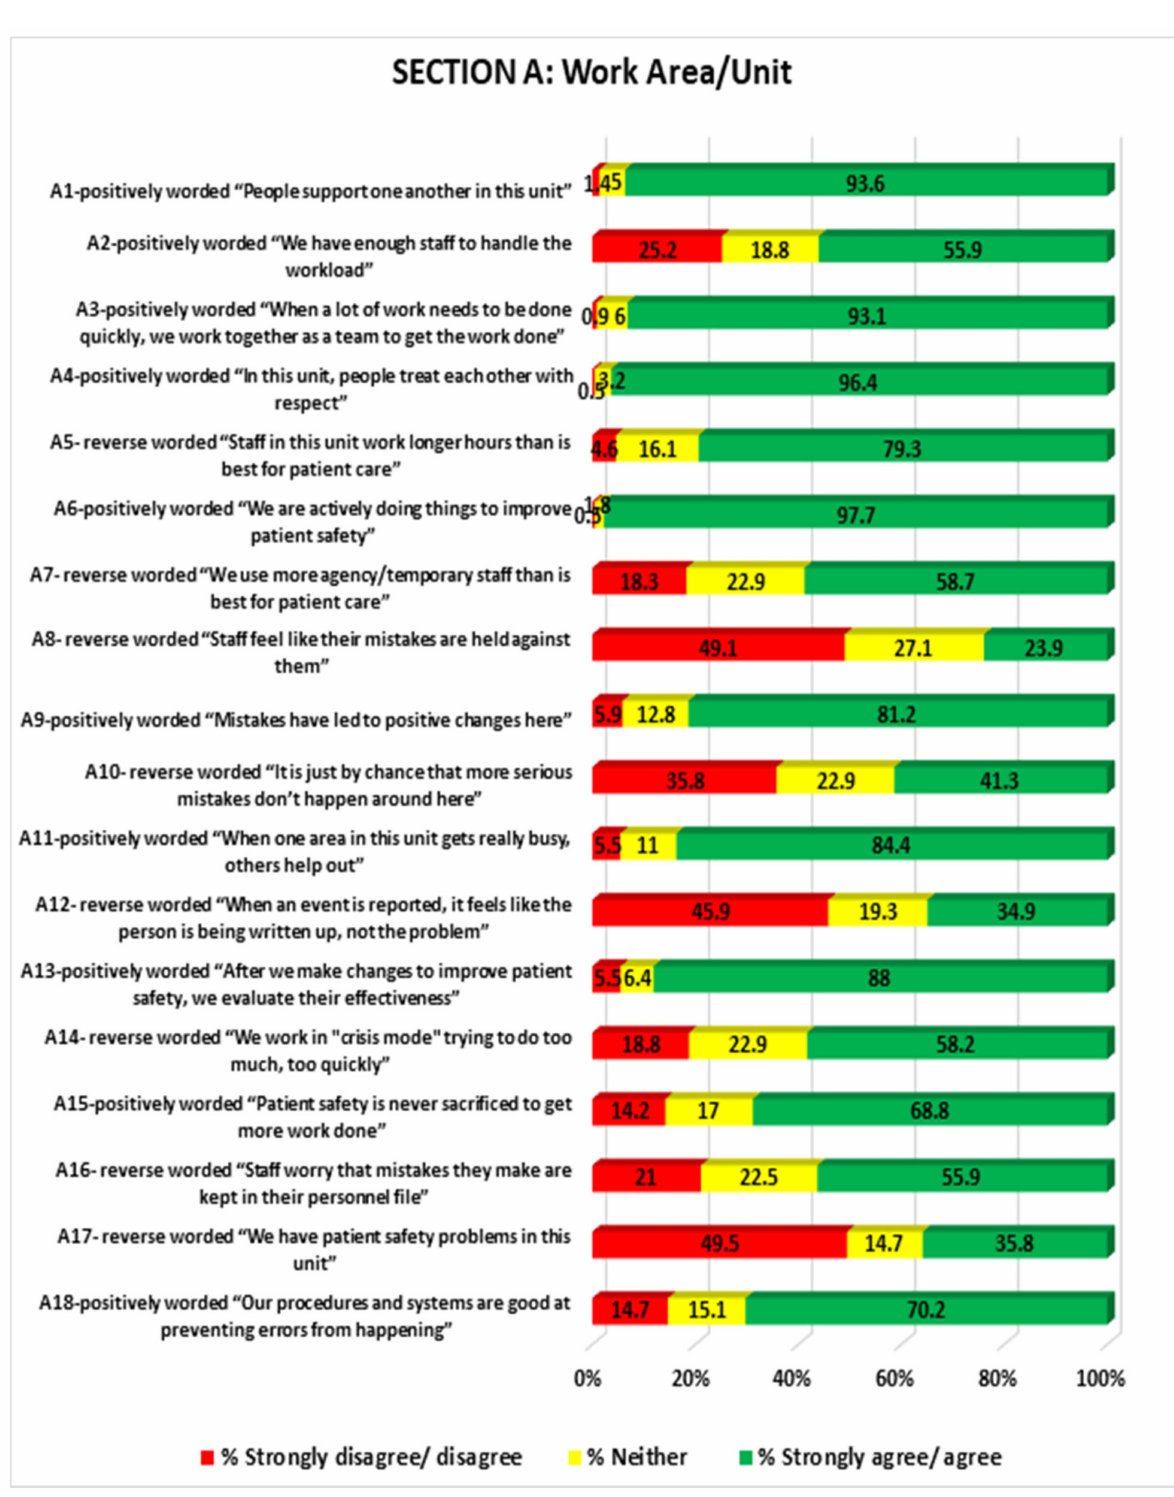
Figure 2. Showing work area/unit patient